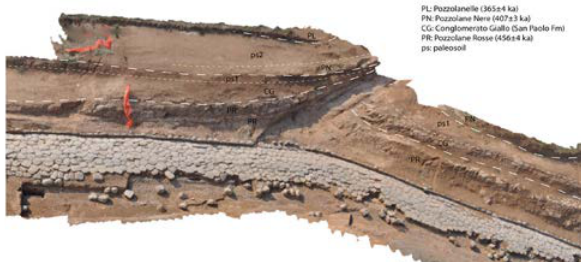
Figure 5. Photo of the Decima archaeological site. The outcrop- ping volcanic formations are labelled, and the stratigraphc limits are shown by the dashed white